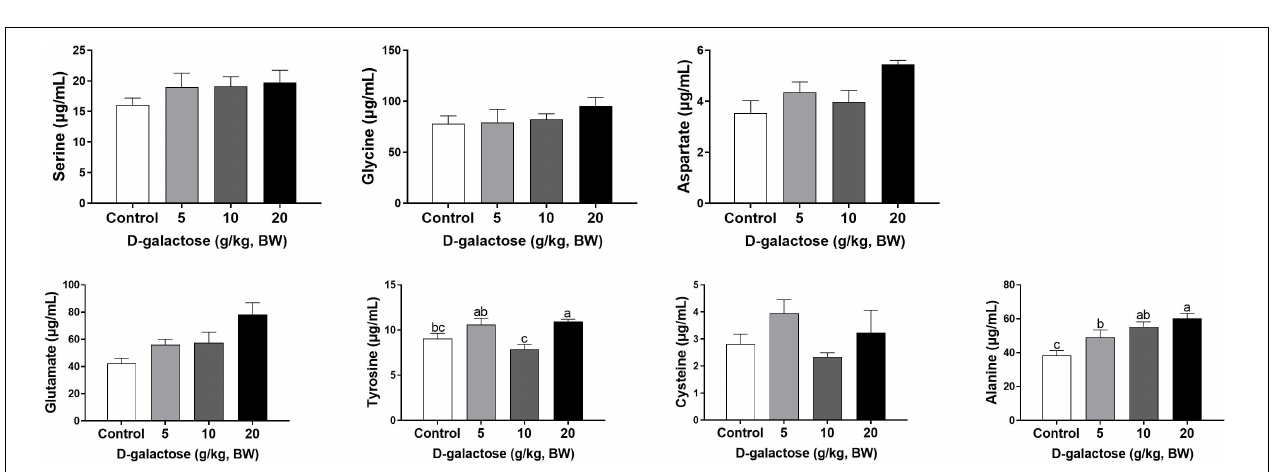
FIGURE 9 | Effects of D -galactose on non-essential amino acids in the serum at the third week. Data were expressed as the mean ± SEM. Different lower-case letters indicate a significant difference among different dosage of D -galactose ( P < 0.05).